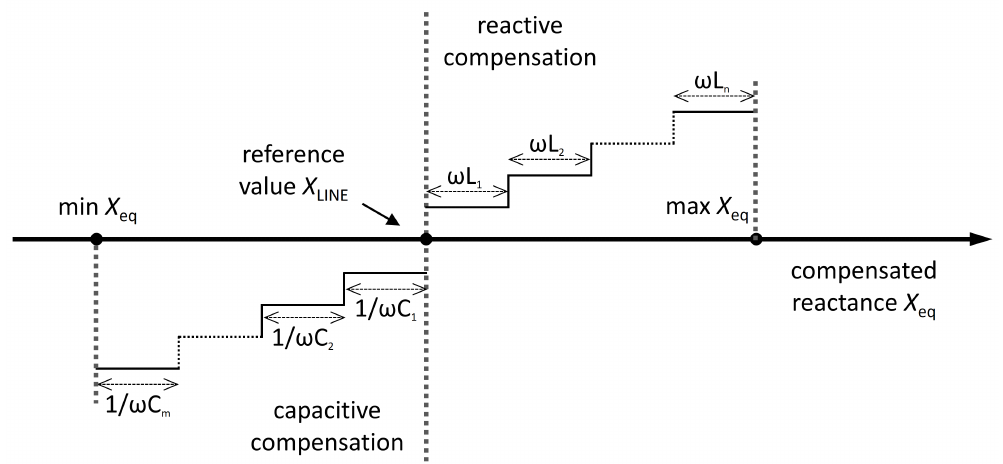
Figure 4. Stepwise capacitive and inductive series compensation of line